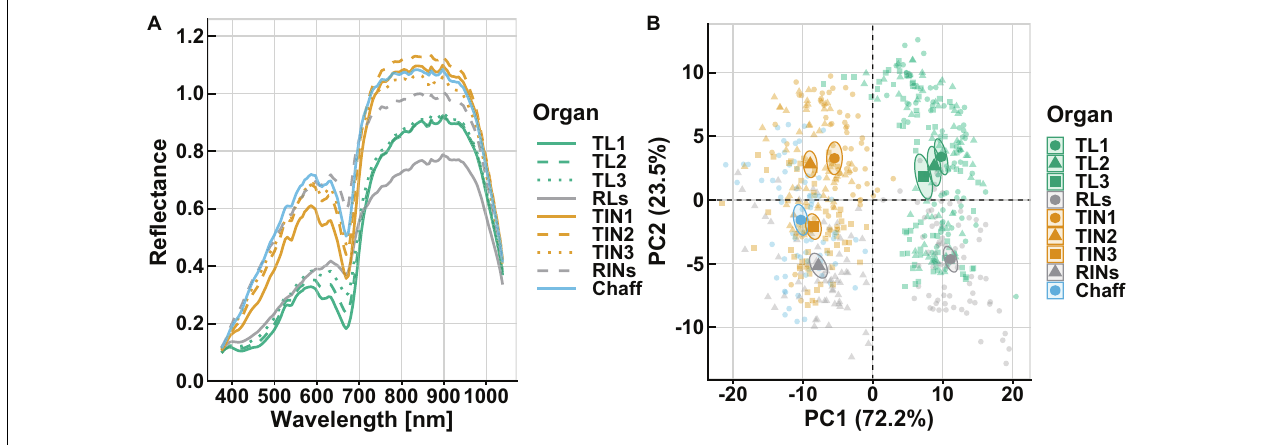
FIGURE 2 | Spectra diversity within and among wheat organs. (A) Mean spectral reflectance for each organ is shown. (B) PCA plots from spectral reflectance categorized by organ group. In PCA plots, the first two PC which explained 95.7% variation, different colors and shapes correspond to each organ category, data points of individual are represented by transparent color points, and confidence ellipse and mean point of each group are shown by solid colors.